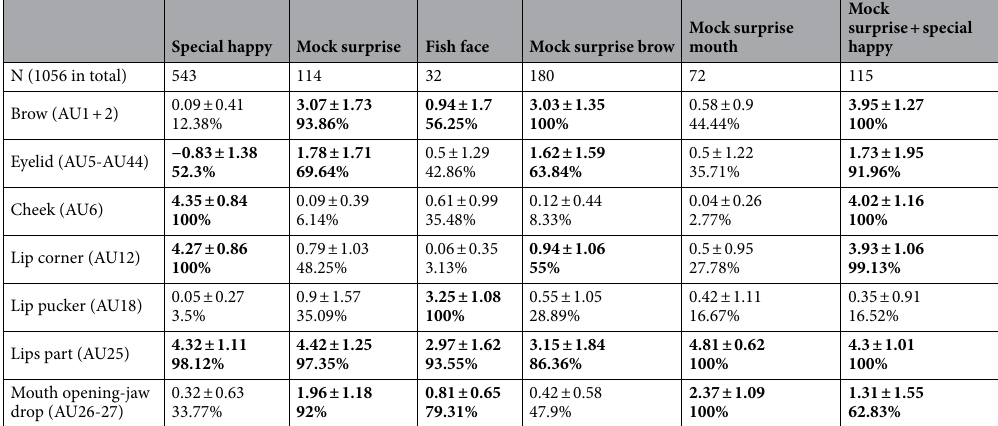
Table 1. Intensity of the facial muscle movements presented as separated Action Units (AUs, mean ± SE) and percentage (%) of AU activation (i.e. intensity score differed from 0) in the six ‘prosodic faces’. Bold highlight represents relevant AUs (i.e. which was active in more than 50% of the